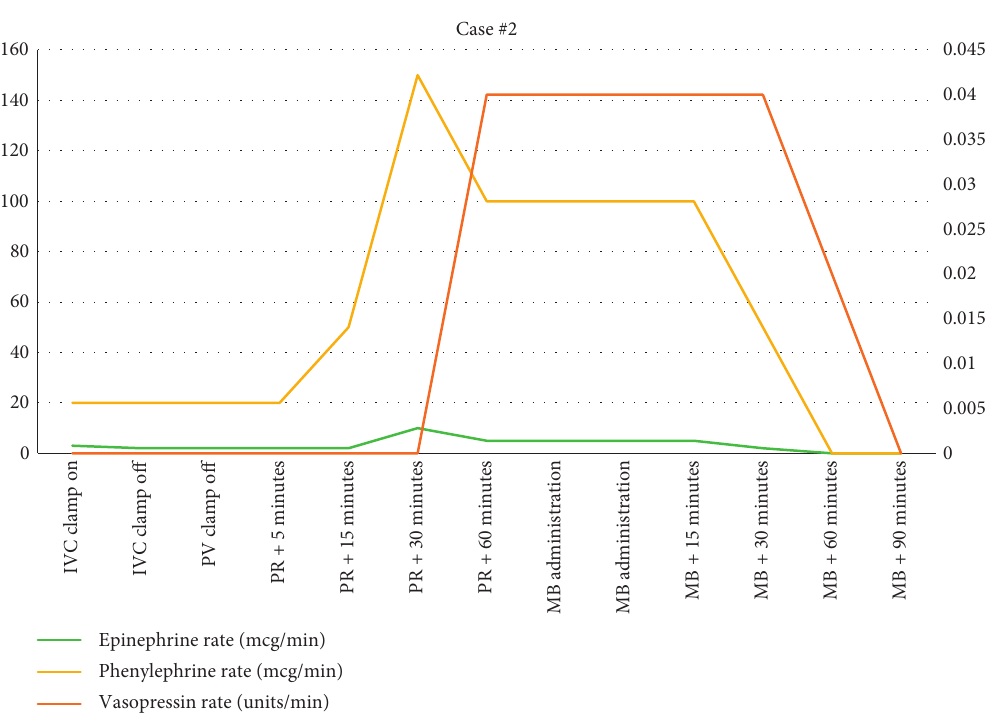
Figure 4: Vasoactive medication use during case